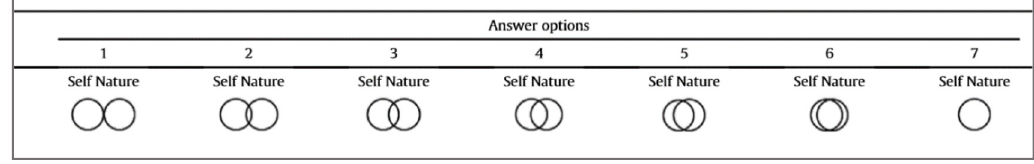
Figure 1. Inclusion of nature in self-scale (Schultz, 2002) used in survey to indicate self-expressed nature affinity . We tested for collinearity between nature affinity and nature deprivation to ensure these two variables independently predict flourishing outcome values. A Spearman cor- relation test of the relationship between nature affinity and feeling nature deprived pro- duced a non-significant − 0.002